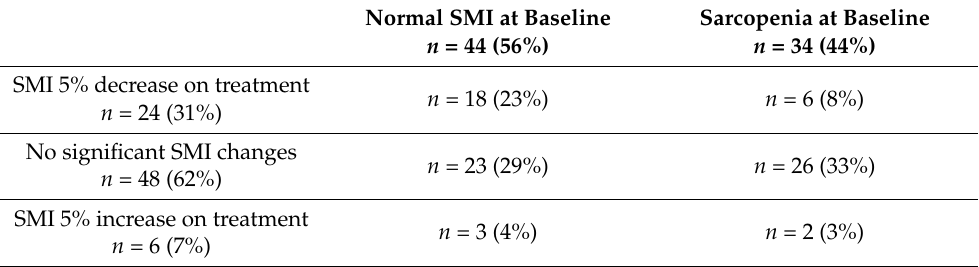
Table 8. Patterns of ‘metabolic’